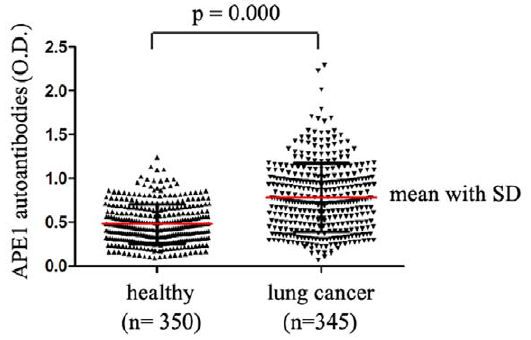
Figure 2. Serum APE1-AAbs level in NSCLC patients and healthy subjects assessed by ELISA. Among 292 NSCLC patients, the mean with SD of APE1-AAbs concentration was 0.79 6 0.40 (OD 450 ), which was significantly higher than 0.47 6 0.22 (OD 450 ) in healthy volunteers ( p =0.000, t -test).